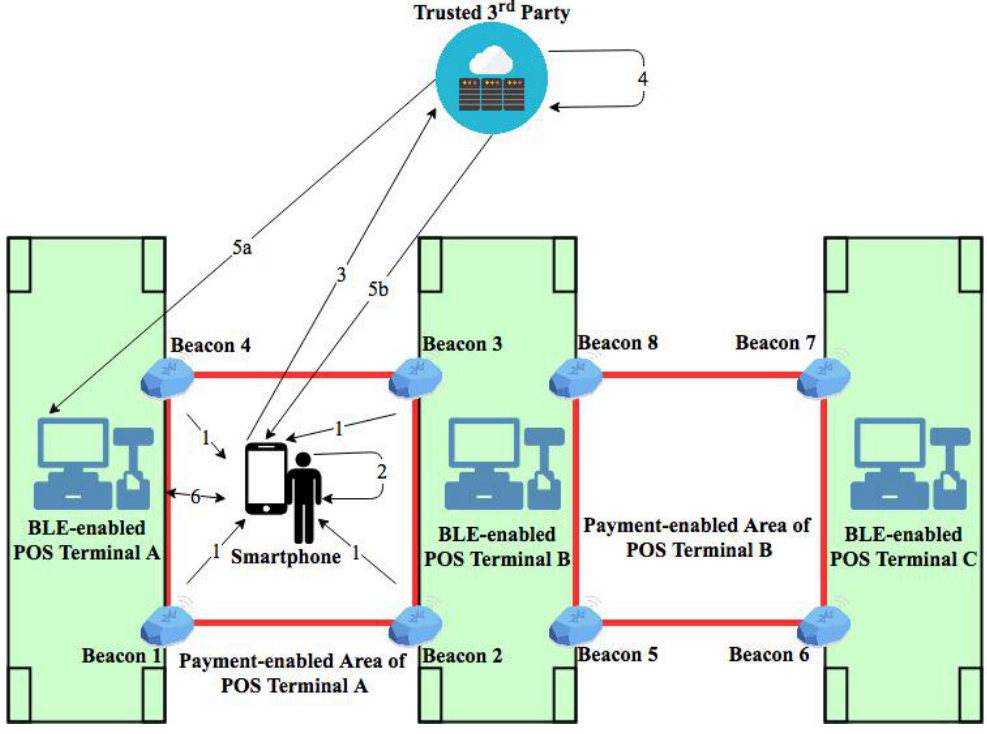
Figure 2. Process flow of the proposed BLE-based mobile payment system is categorized into 6 steps: